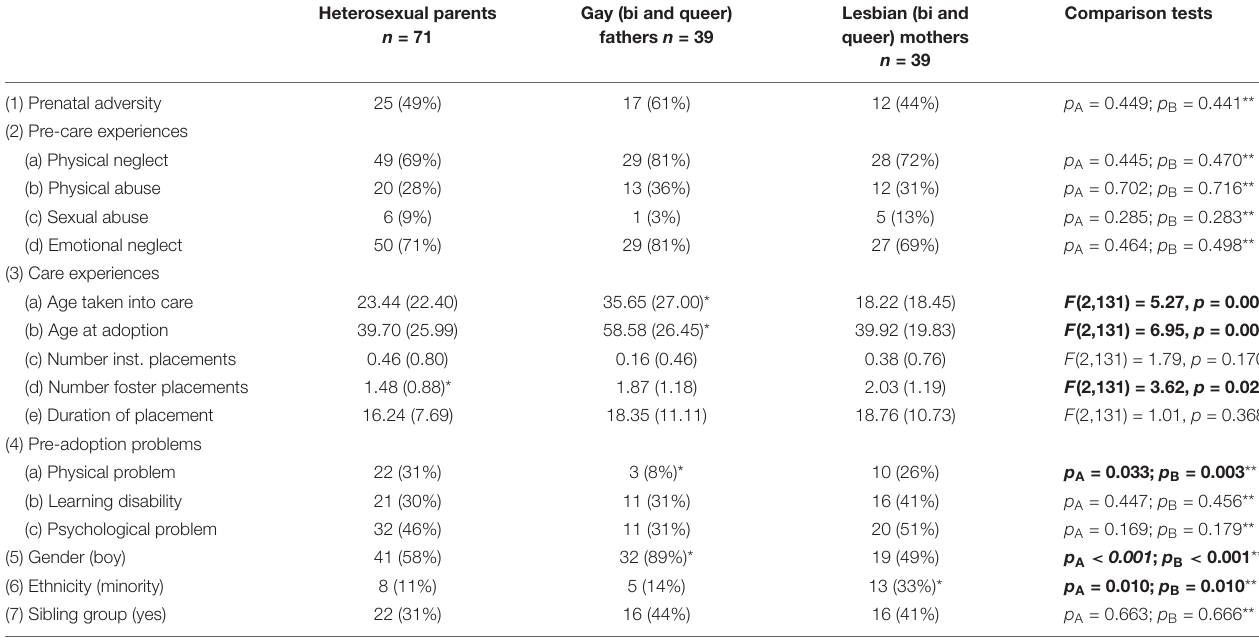
TABLE 2 | Comparisons across family groups on children’s hard-to-place